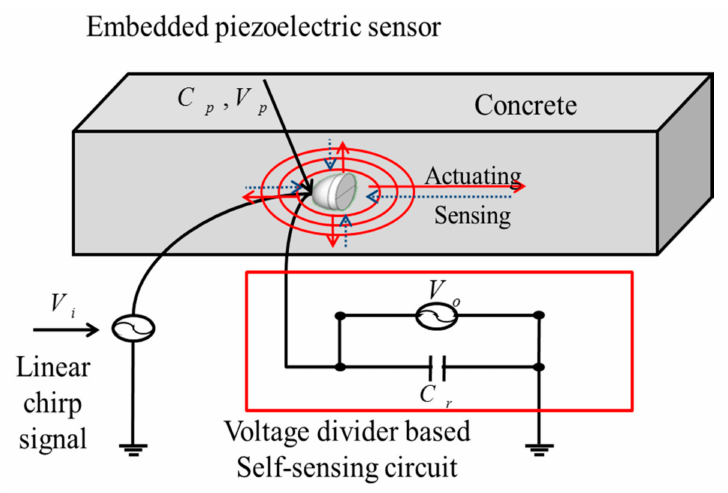
Figure 2. A schematic diagram of the sensor in concrete and the data acquisition